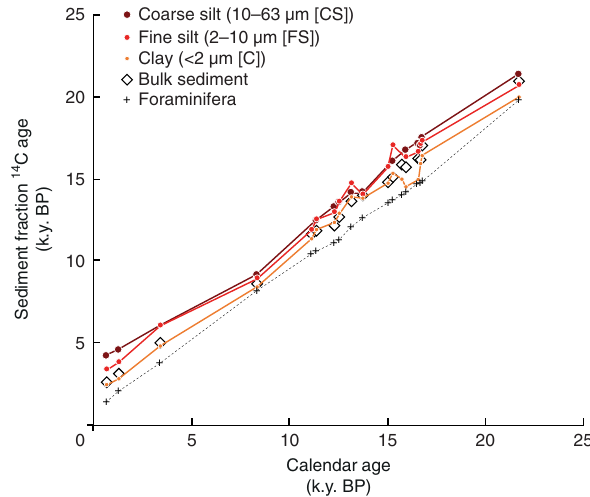
Fig. 2 Down-core age relationships among grain-size sediment